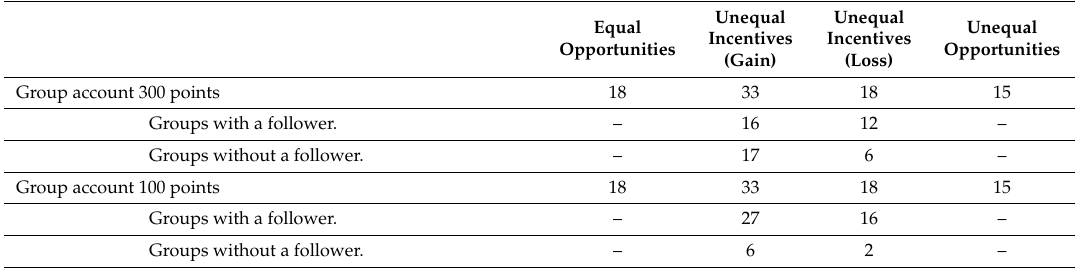
Table A1. Number of groups in the different treatments and their